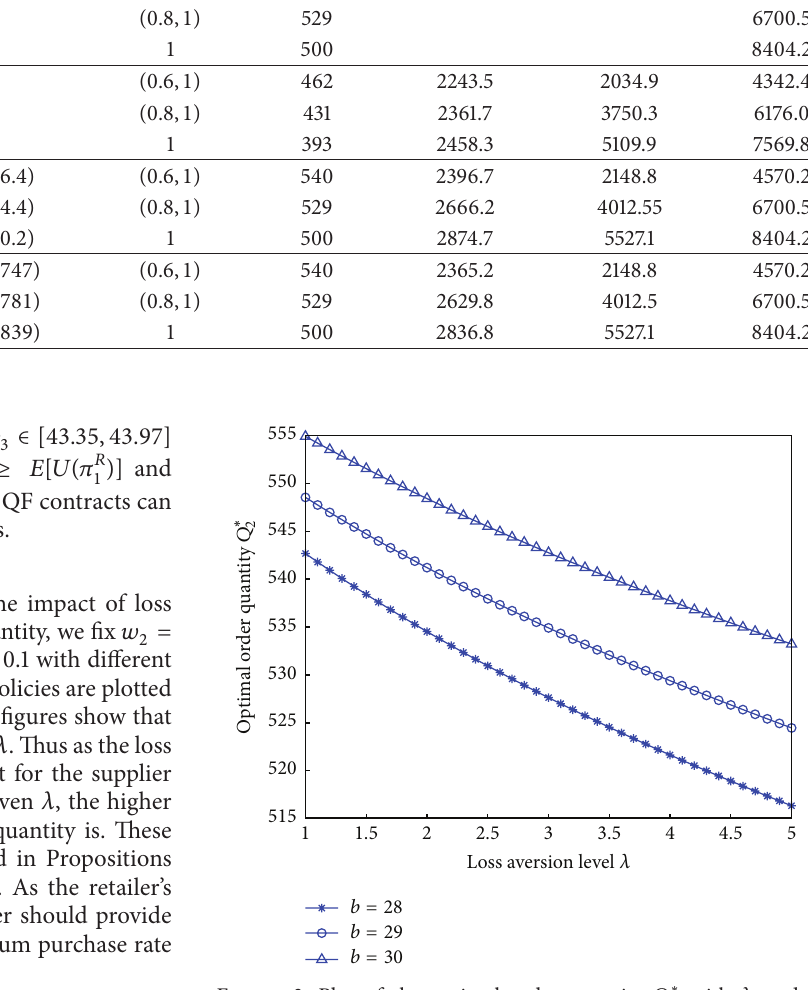
Figure 3: Plot of the optimal order quantity 𝑄 ∗ 2 with 𝜆 under different values of 𝑏